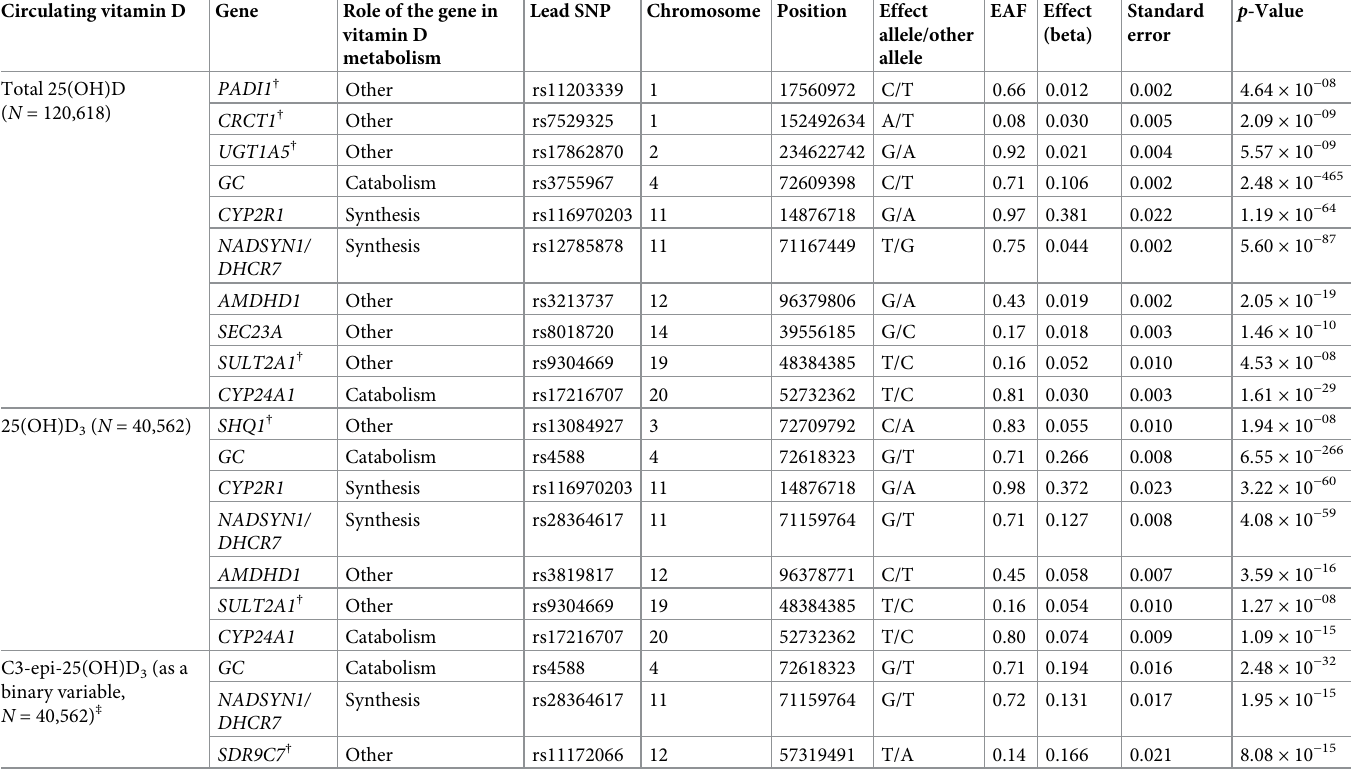
Table 2. Genetic loci identified in the genome-wide analyses for circulating 25(OH)D metabolites. Circulating vitamin D Gene